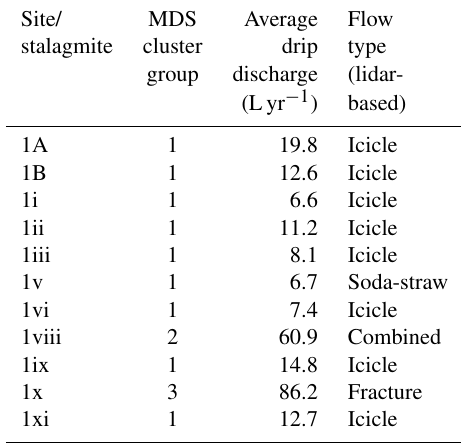
Figure 5. Hydrological behavior of drip sites expressed in terms of daily mean discharge versus daily discharge variability calcu- lated from the automatic drip rate data for three hydrological years. Measured drip rates are converted to volume units assuming a drip volume of 0.1433mL (Genty and Deflandre, 1998). Blue lines and symbols reflect flow classification given in Mahmud et al. (2015).